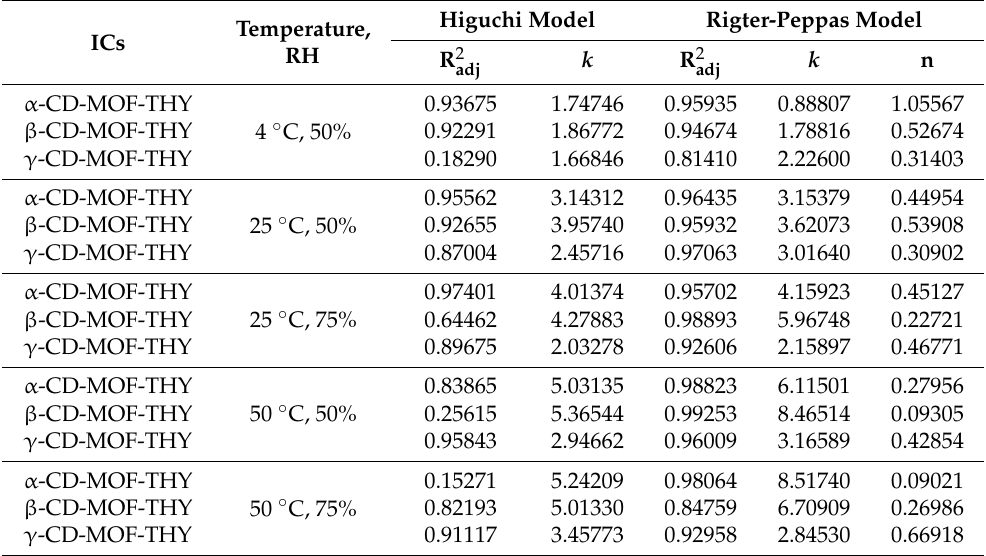
Table 1. Kinetic constants and correlation coefficients of inclusion complexes release based on different models. Higuchi Model Rigter-Peppas Model Temperature, ICs RH R 2 adj